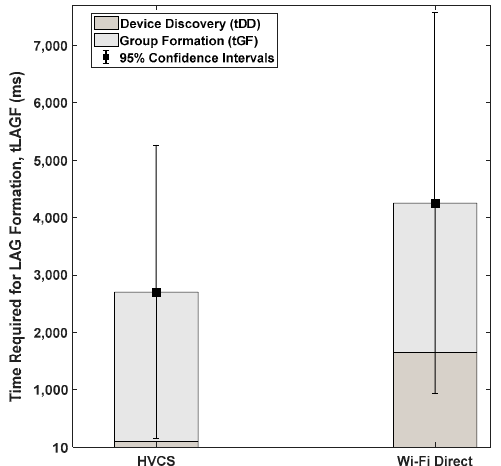
Figure 7. Comparison between the time taken for the LAG formation of HVCS and Wi-Fi Direct.